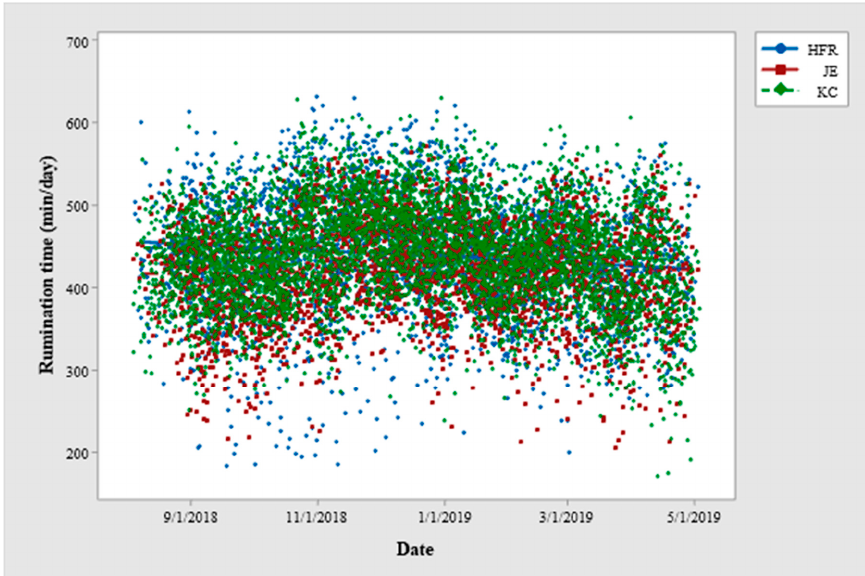
Figure 5. Scatterplot between date and rumination time (min/day) for Holstein-Friesian (HFR), Jersey (JE) and KiwiCross (KC) cows across the lactation period for Year-1 of the study period. (The scatterplot is based on the raw values of rumination time).